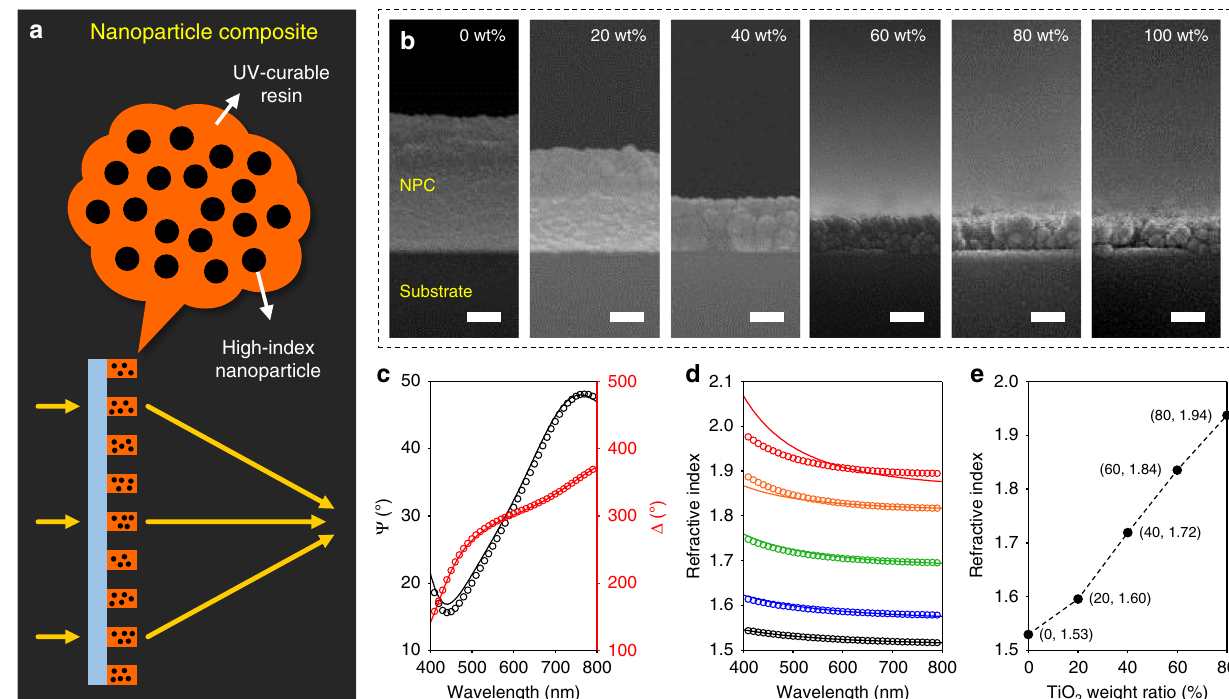
Fig. 1 Characterization of the nanoparticle composite. a Schematic of the plum pudding metalens (PPML). Yellow lines: light propagation direction through the PPML. The PPML can be fabricated with a single step of printing at low cost due to the compatibility of the nanoparticle composite (NPC). The refractive index of the NPC is high enough to realize metalenses, so the NPC can be directly used as a material of metalenses without any secondary operations such as thin- fi lm deposition or etching. b Scanning electron micrographs of cross sections of the spin-coated NPC fi lms with different weight ratios of titanium dioxide (TiO 2 ) nanoparticles. Spin-coating conditions are the same for all samples. The particle size is much smaller than the operating wavelength, so the NPC can work as a homogeneous effective medium. All scale bars: 150 nm. c Ellipsometry analysis of the NPC fi lm with 80% of the TiO 2 weight ratio. The amplitude component is denoted by Ψ while the phase difference is represented as Δ . Real lines: theoretical prediction by the Cauchy dispersion model; circles: experimental measurements. d Comparison of the refractive index of the NPC fi lms. Real lines: retrieved data from the ellipsometry measurement of each NPC fi lm with different TiO 2 weight ratio (black: 0%; blue: 20%; green: 40%; orange: 60%; red: 80%); circles: calculated data by the Maxwell – Garnett formula with different volume fraction of TiO 2 nanoparticles (Black: 0%; blue: 7%; green: 20%; orange: 33%; red: 41%). e The measured refractive index variation of the NPC fi lms by the weight ratio at the wavelength of 532 nm. The dashed line is to guide the